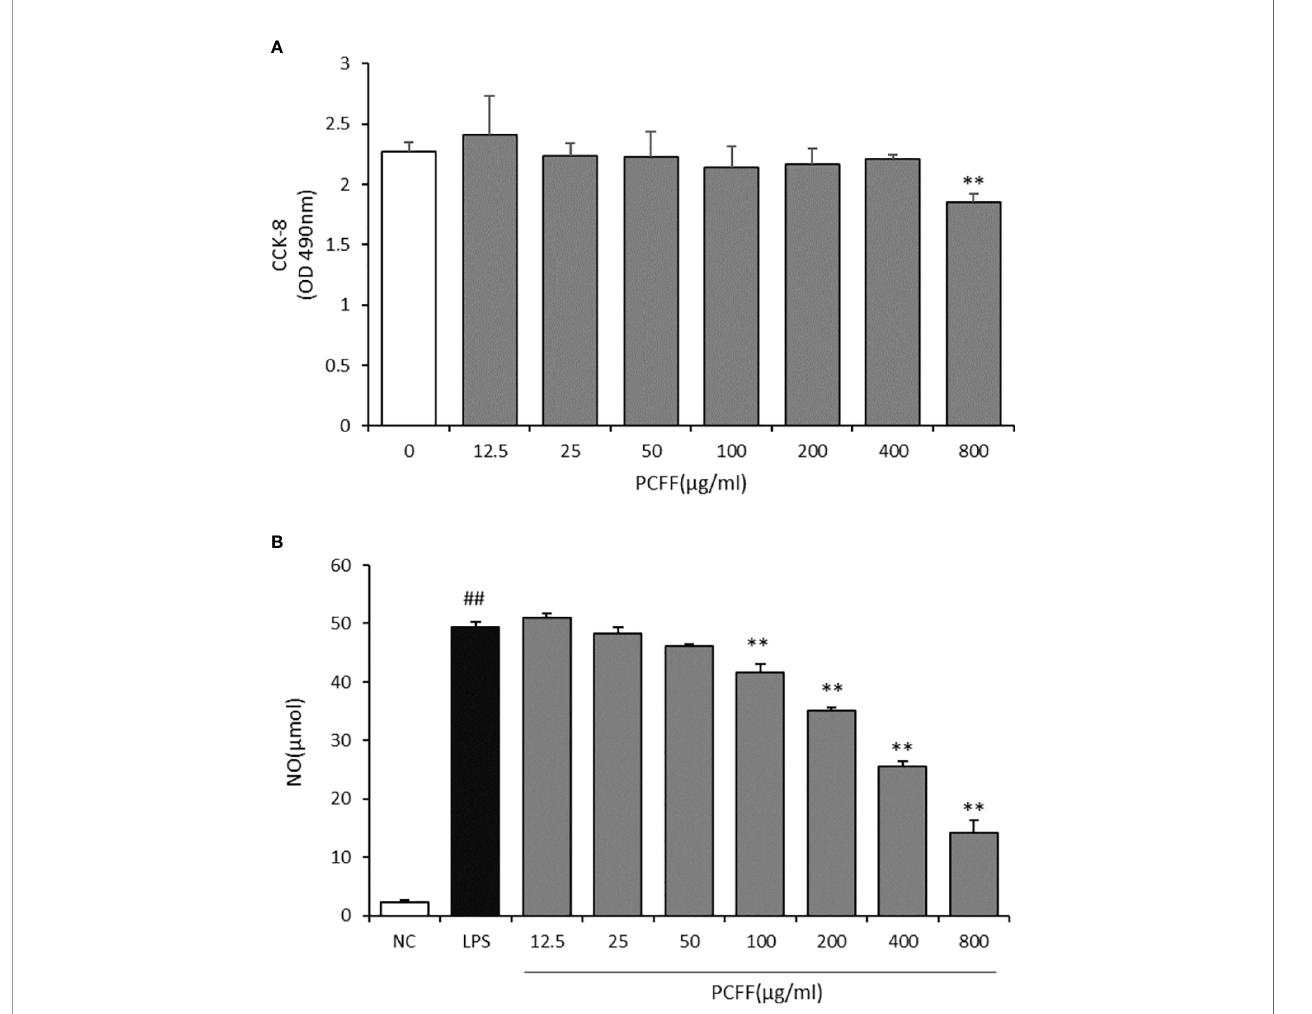
FIGURE 5 | Cytotoxicity of PCFF on RAW264.7 cells and effects of PCFF on LPS-induced NO production in RAW264.7 cells. (A) Each value indicates the mean ± SD from three independent experiments. Compared with untreated group, **P <0.01; (B) Compared with NC group, ## P < 0.01; compared with LPS group, **P